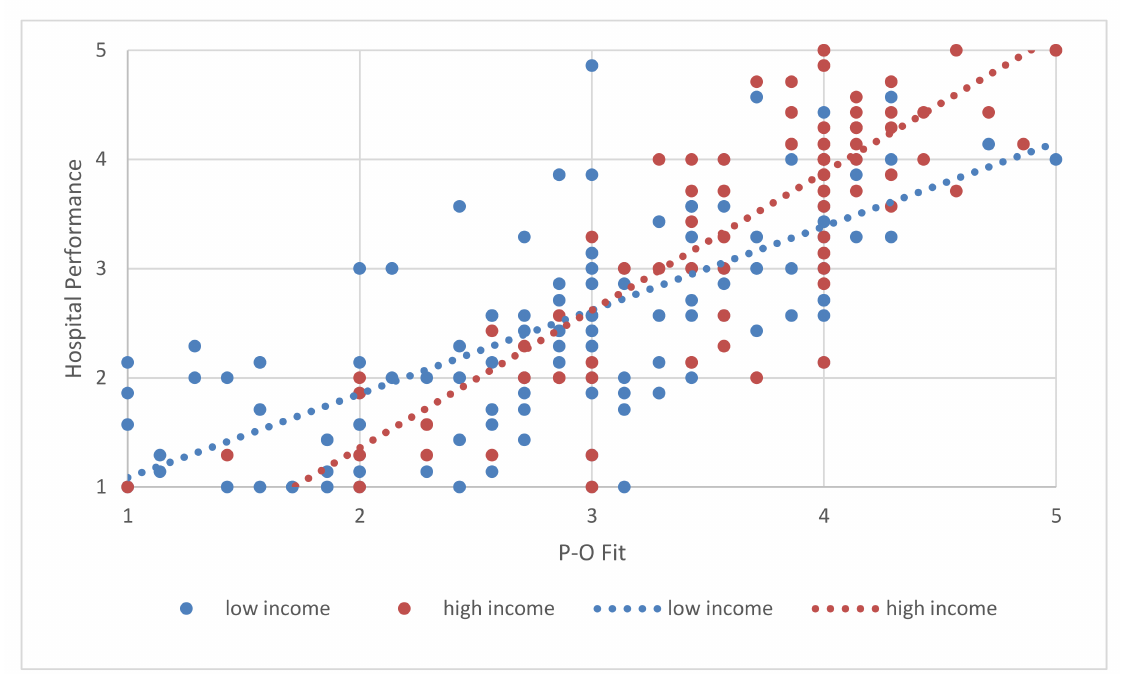
Figure A2. Correlation between job satisfaction and hospital performance categorized by income.